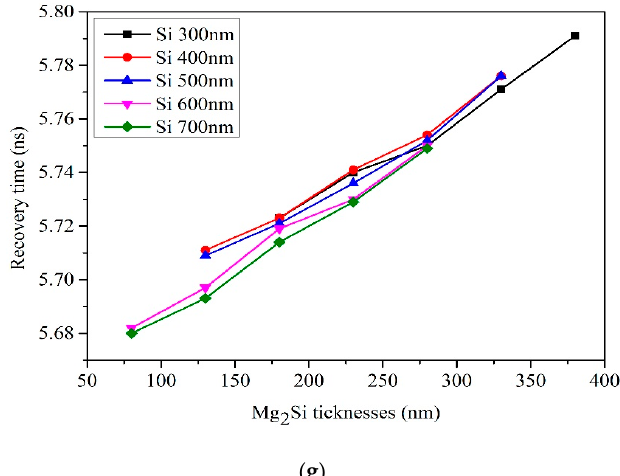
Figure 12. The response time and recovery time curves of heterojunction PD with different Mg 2 Si thicknesses under the condition of 300 nm, 400 nm, 500 nm, 600 nm, and 700 nm thicknesses of Si. ( a ) Si-300 nm; ( b ) Si-400 nm; ( c ) Si-500 nm; ( d ) Si-600 nm; ( e ) Si-700 nm; ( f ) The effect of thicknesses on the response time; ( g ) The effect of thicknesses on the recovery time.